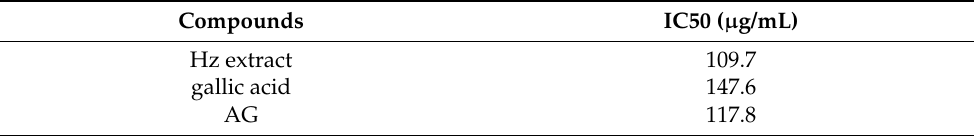
Table 4. IC50 value of synthetic or natural compounds: total hazelnut extract, gallic acid, and aminoguanidine. The concentration required for a 50% inhibition of the intensity of fluorescence (l = 365/440 nm) was calculated from the dose–inhibition curve, obtained by GraphPad analysis ( n =